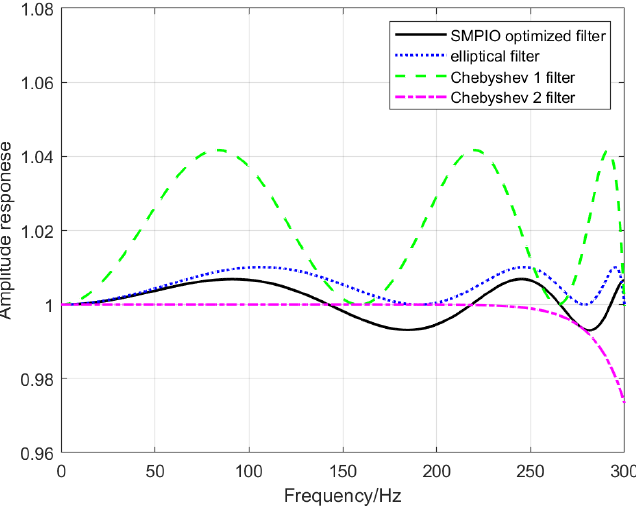
Figure 6. Amplitude response comparison of various types of filters (0 Hz~300 Hz, m = 6, amplitude optimized).